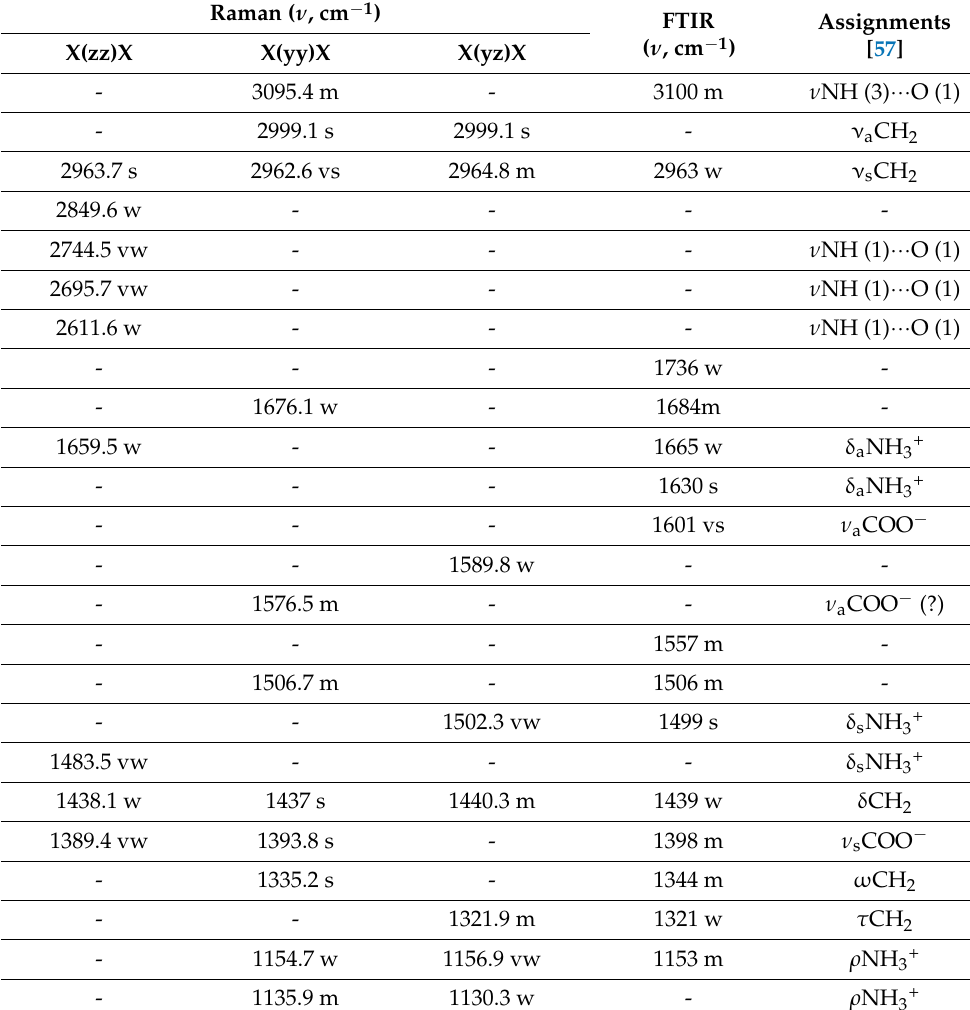
Table 8. Positions of lines ( ν , cm − 1 ) observed in polarized Raman and FTIR spectra of γ -Gly:CA (80:20) crystals and assignments of analogous lines in nominally pure γ -Gly from Ref. [58]. Raman ( ν , cm − 1 )